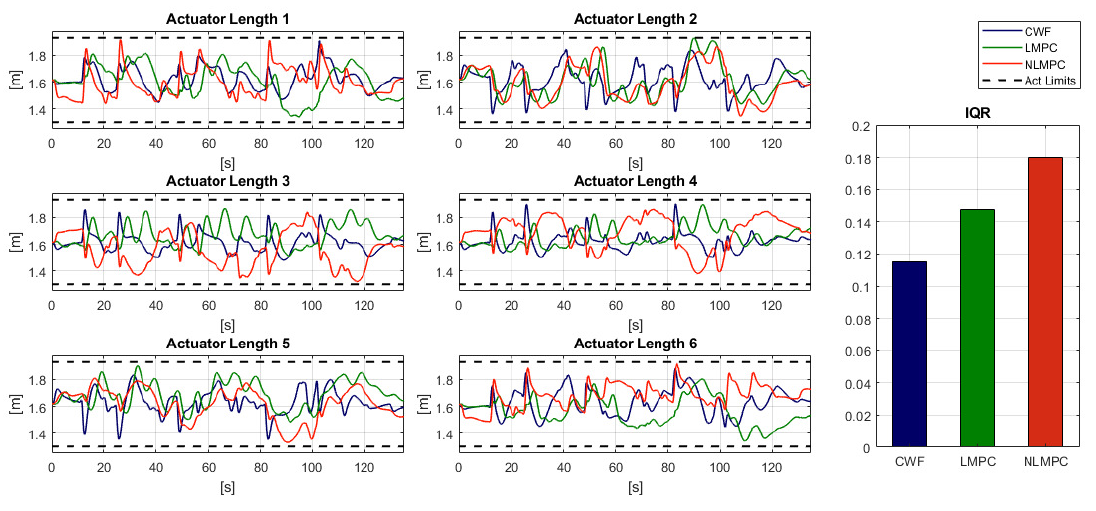
Figure 15. Workspace Use: Actuator Displacement and Mean